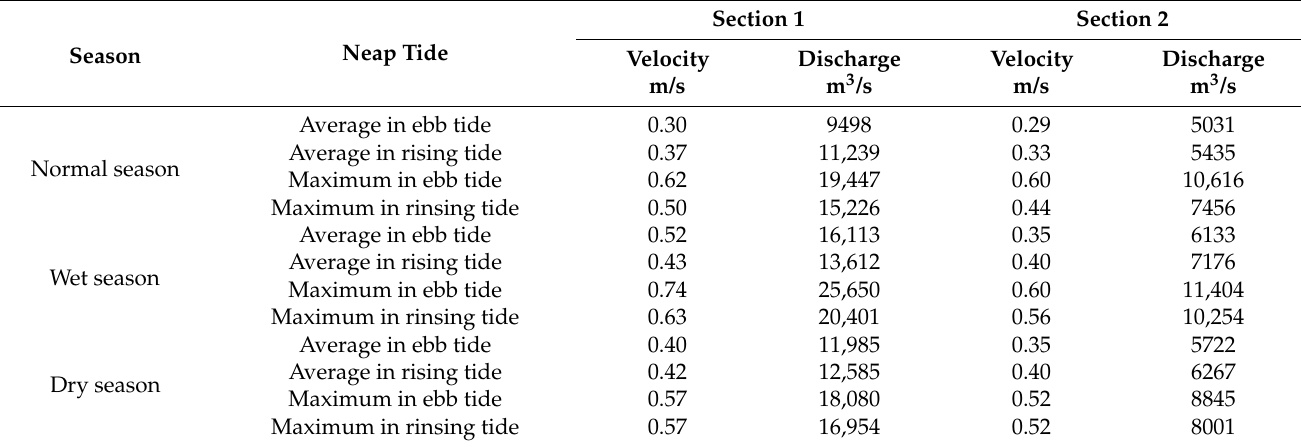
Table 2. Statistics of Section Navigation Observation Data in Neap